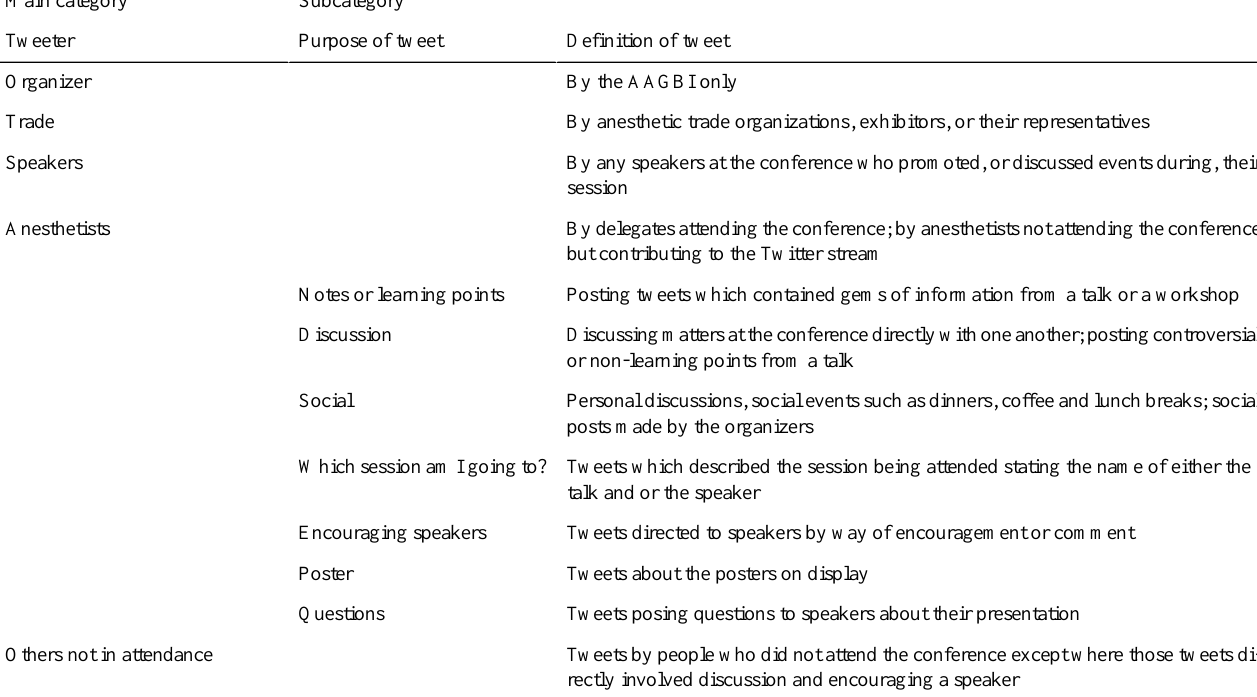
Table 2. Tweets sent during the January 2012 Association of Anaesthetists of Great Britain and Ireland (AAGBI) conference. SubcategoryMain category